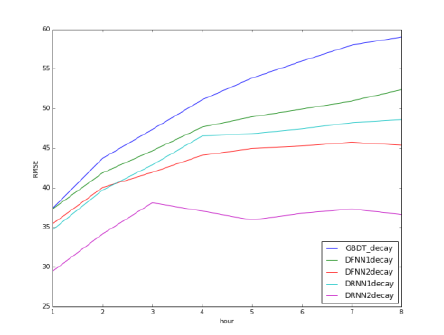
Figure 6. RMSE of DRNN2 models